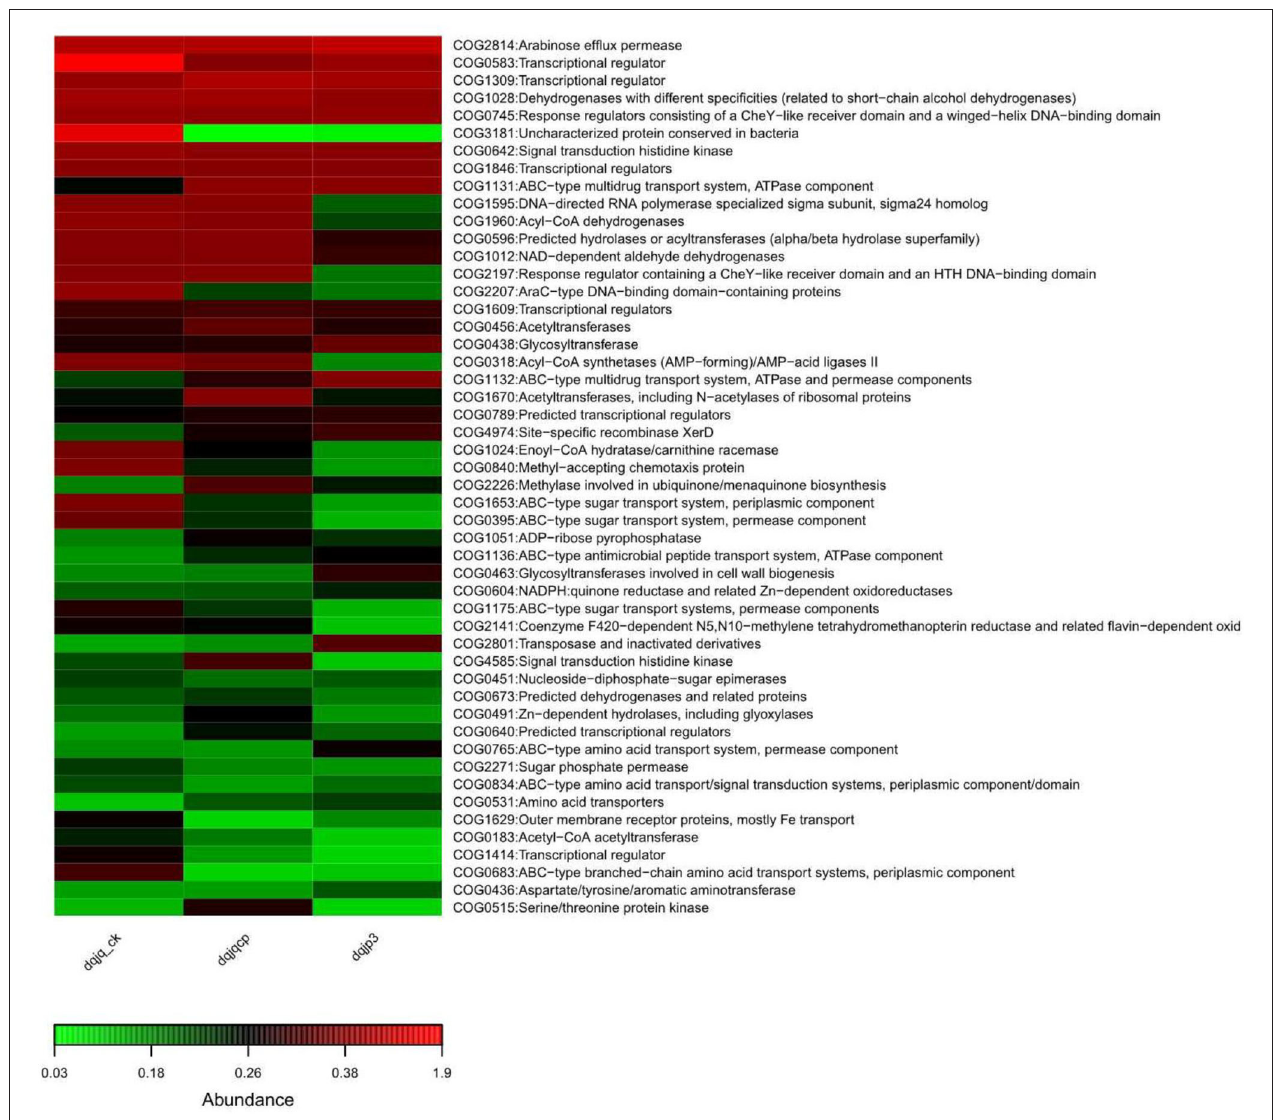
FIGURE 5 | Overview of the bacterial COG profile in three